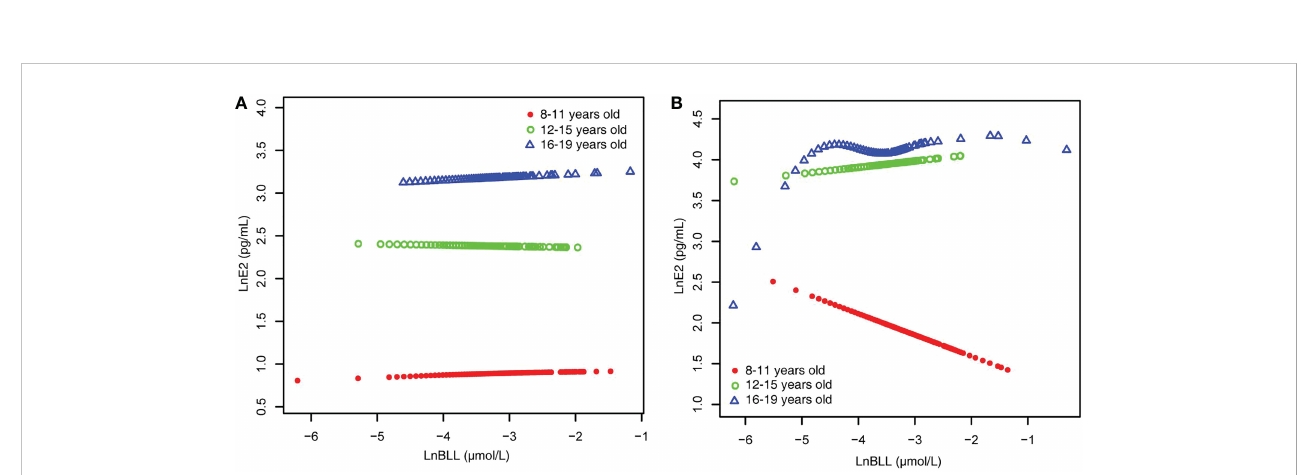
FIGURE 3 BLL and E2 dose – response relationship, strati fi ed by age. (A) male. (B) female. Adjusted for ratio of family income to poverty; total energy, cholesterol, Ln (iron) and Ln(zinc) intake on the fi rst day; fi sh eaten during the past 30 days, moderate recreational activities, body mass index and Ln(serum copper). BLL, Blood lead levels; E2, Estradiol.